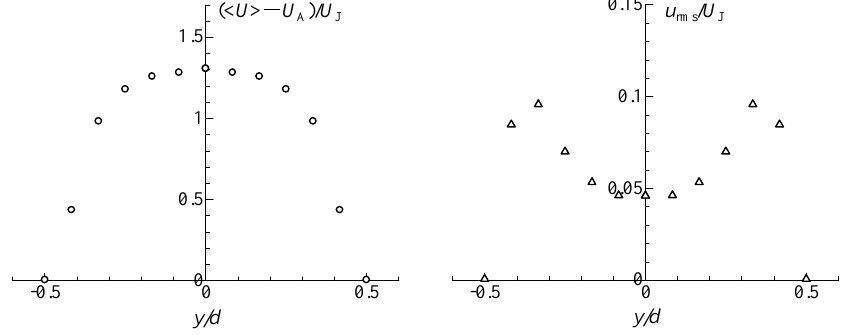
-0.5 Fig. 3 The lateral profiles of the mean streamwise velocity and the rms value of streamwise velocity fluctuation at x = d = 0 : 25. through a rectangular slit with a width of d = 2 mm and a spanwise length of l S = 40 mm (the aspect ratio l S = d =